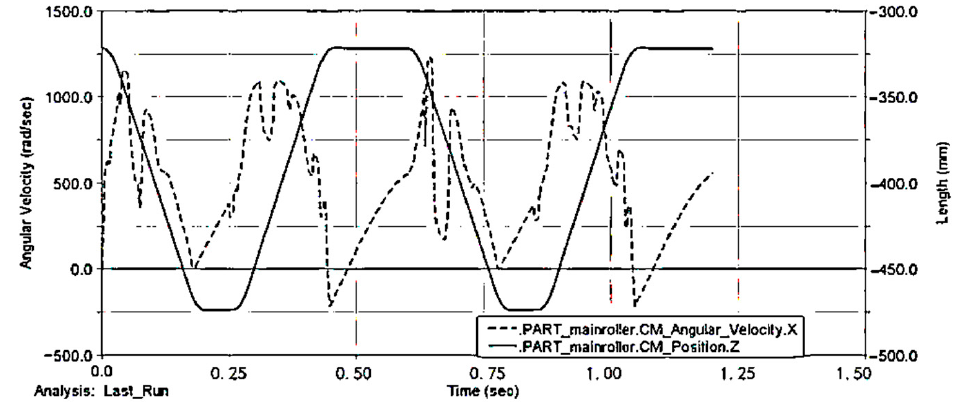
Figure 13. The motion change curve of the main roller without the consideration of recoil and gap.